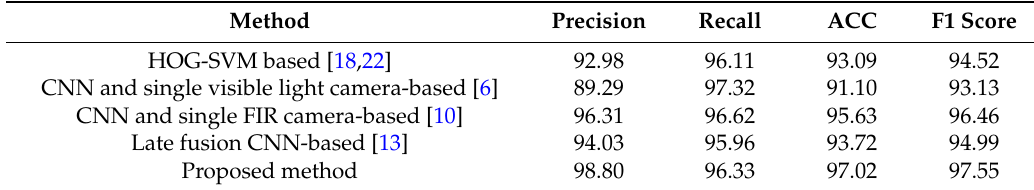
Table 11. Comparisons of classification accuracies with degraded DVLFPD-DB1 based on precision, recall, accuracy, and F1 score (unit: %).